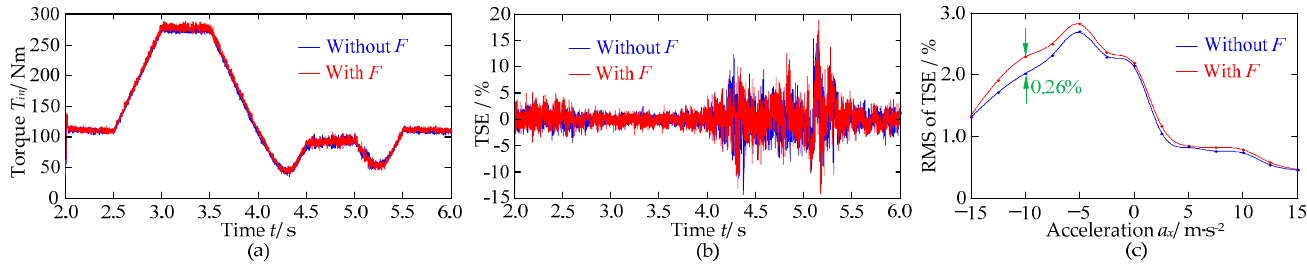
Figure 14. Torque and TSE when a x changes from 10 to − 10 m·s − 2 : ( a ) torque of PMSMs; ( b ) TSE; ( c ) the changes in RMS of TSE with a x .